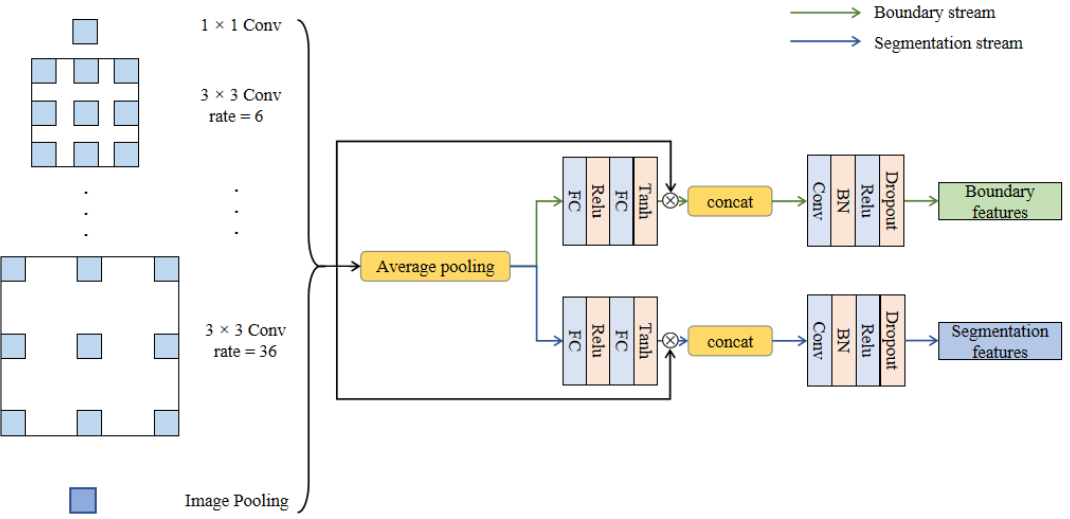
Figure 6. Cross-modal atrous spatial pyramid pooling module structure.